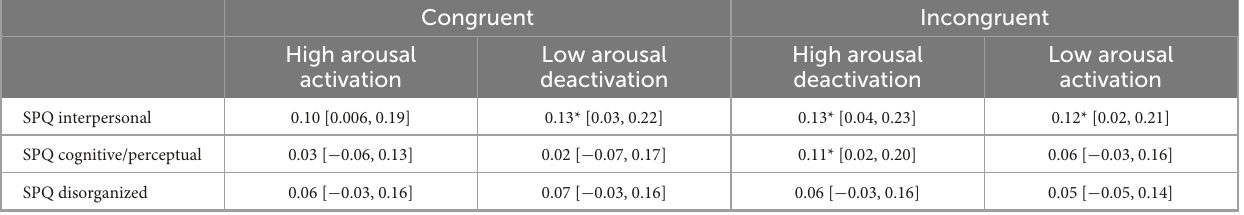
TABLE 2 Correlations between schizotypy dimensions and congruent/incongruent bodily sensations of